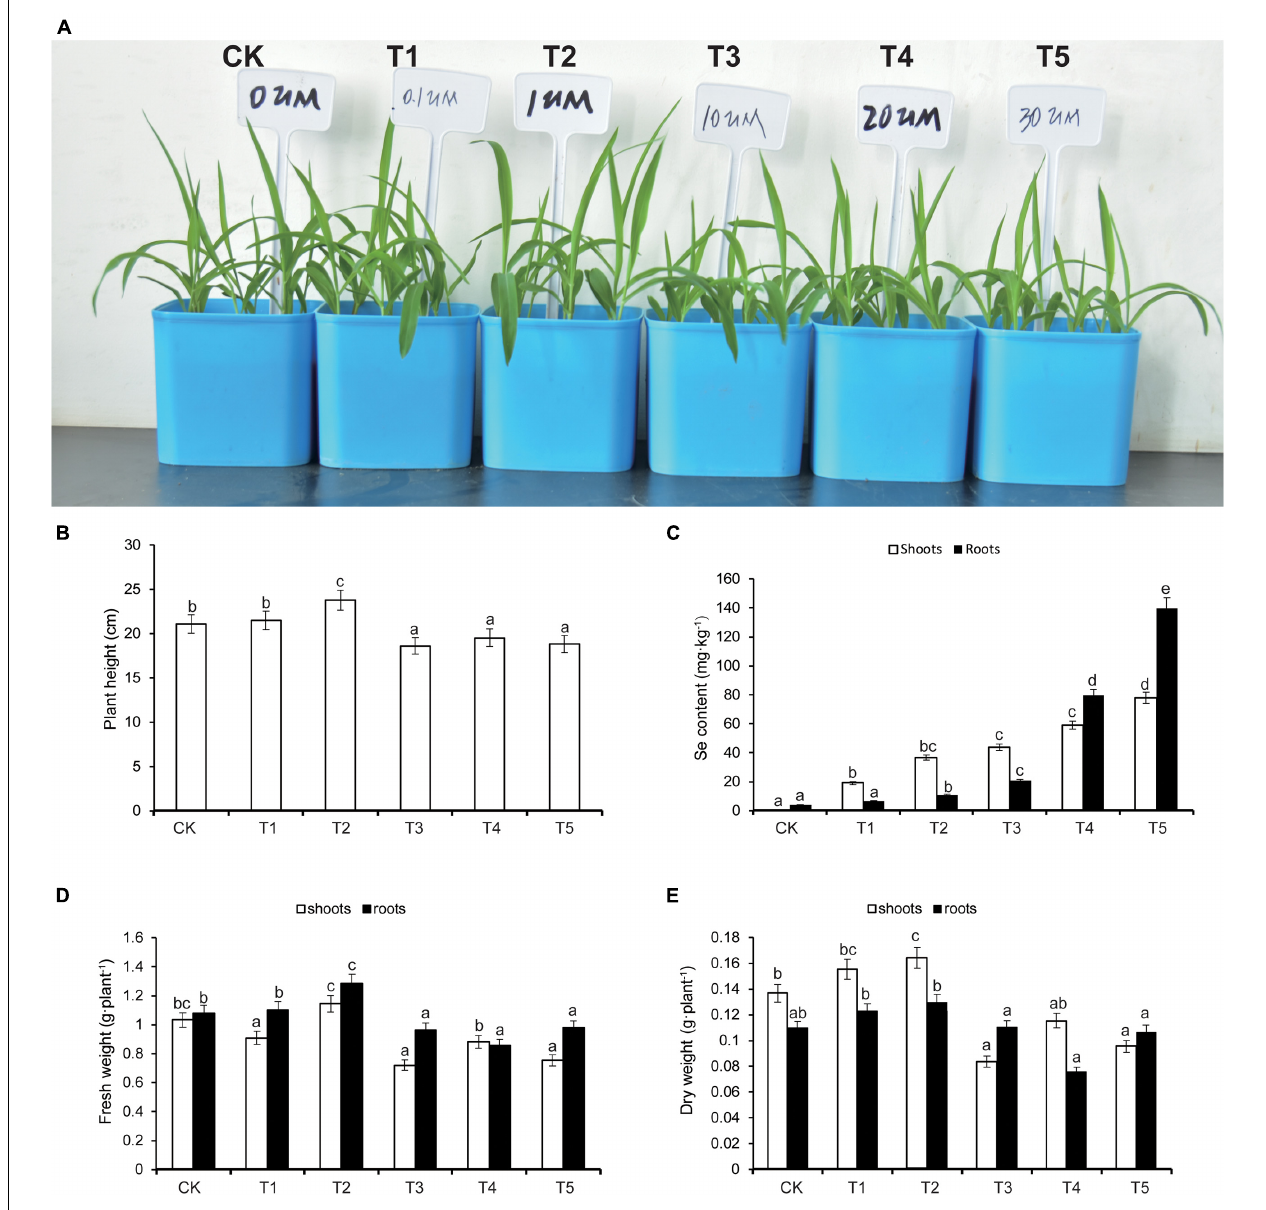
FIGURE 1 | Effects of selenium (Se) treatment on plant growth (A) , plant height (B) , Se content (C) , fresh weight (D) , and dry weight (E) in the shoots and roots, respectively. Different treatments were added with or without different concentrations of Se. The abbreviations of CK, T1, T2, T3, T4, and T5 indicates 0 µ M Na 2 SeO 3 , 0.1 µ M Na 2 SeO 3 , 1 µ M Na 2 SeO 3 , 10 µ M Na 2 SeO 3 , 20 µ M Na 2 SeO 3 , and 30 µ M Na 2 SeO 3 , respectively. The statistical significance was determined using a one-way ANOVA combined with Tukey’s test. Columns labeled with different letters between treatments represent significant differences ( p ≤ 0.05). Data are presented as mean ± SE ( n =